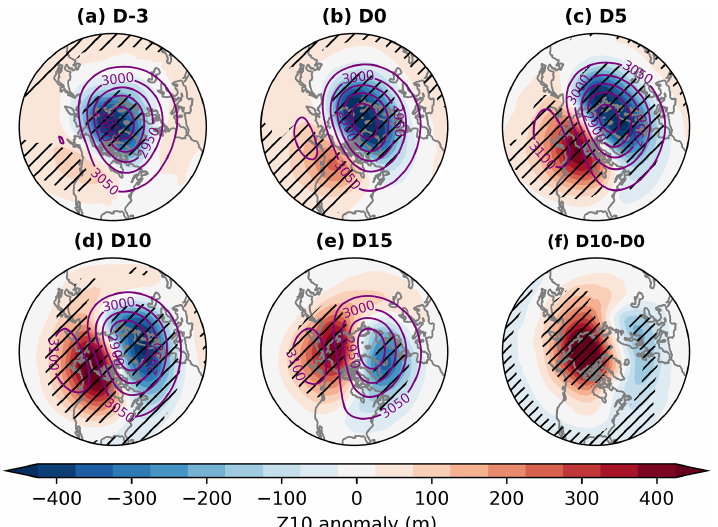
Figure A4. (a–e) Composite-mean 10hPa geopotential height (Z10, contours, dam) and Z10 anomalies (shading, m) at various lags relative to the reflection event onset. (f) Average difference between the Z10 anomalies on day 10 and day 0 (i.e. d – b ). Hatching denotes statistically significant anomalies, assessed as described in Sect.